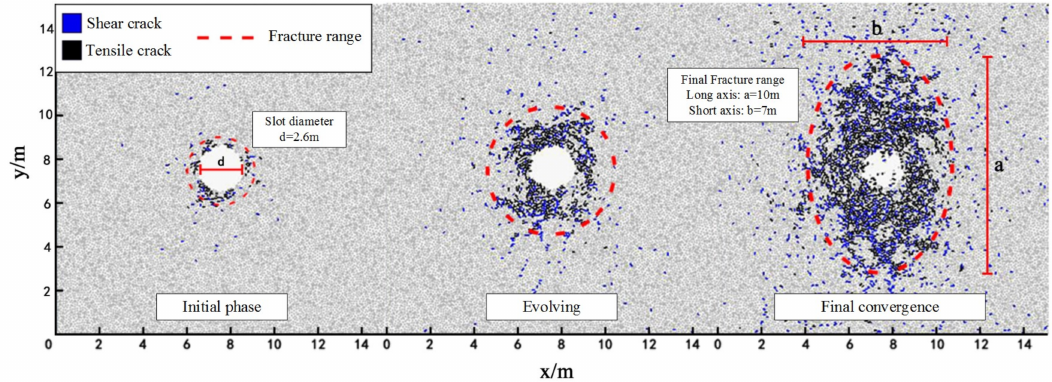
Figure 13. Simulation results showing evolution of coal fractures under two-dimensional